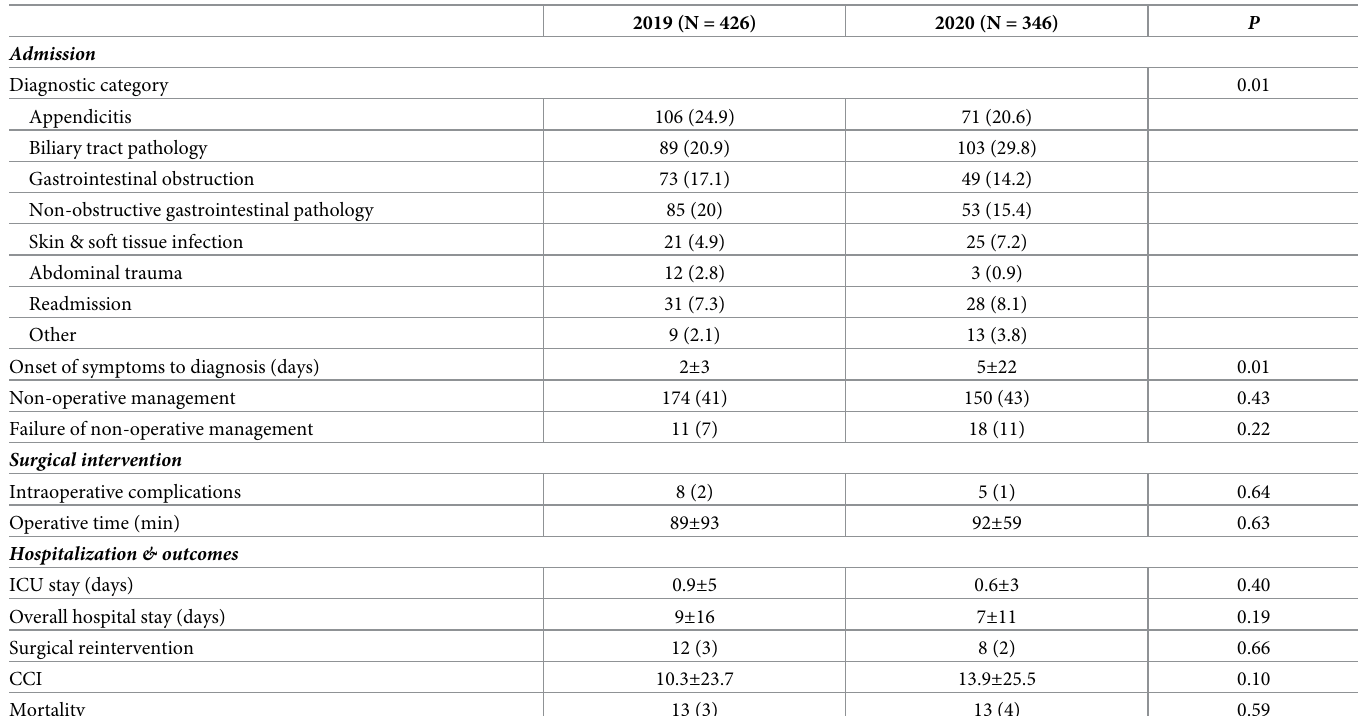
Table 2. Data related to